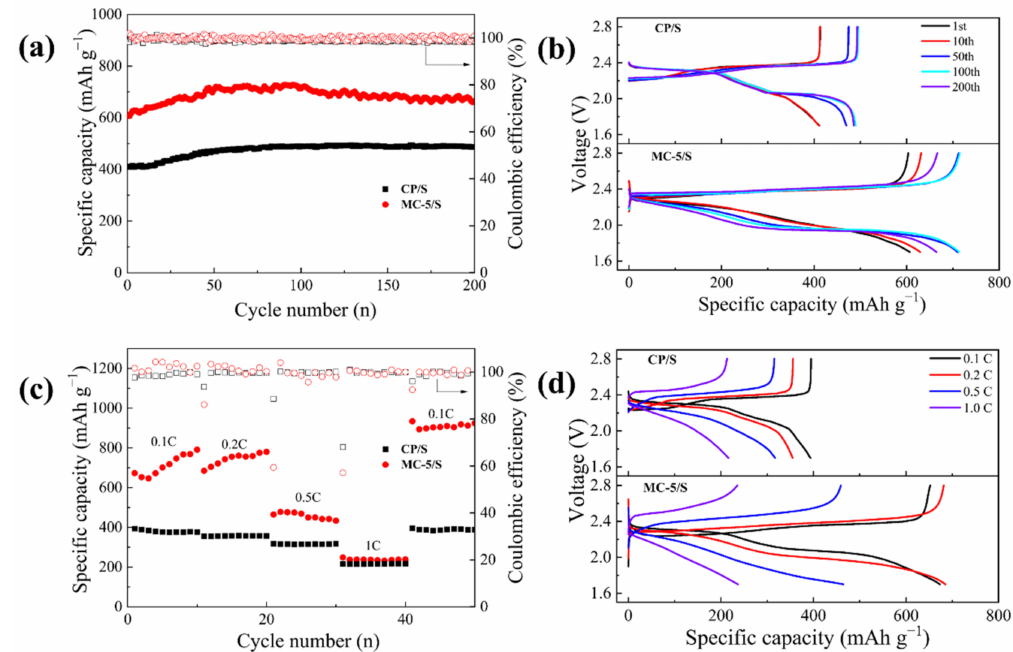
Figure 5. Cycle performance ( a ) and rate property ( c ) of the CP and MC-5 as collectors in Li–S batteries with the corresponding charge/discharge profiles ( b , d